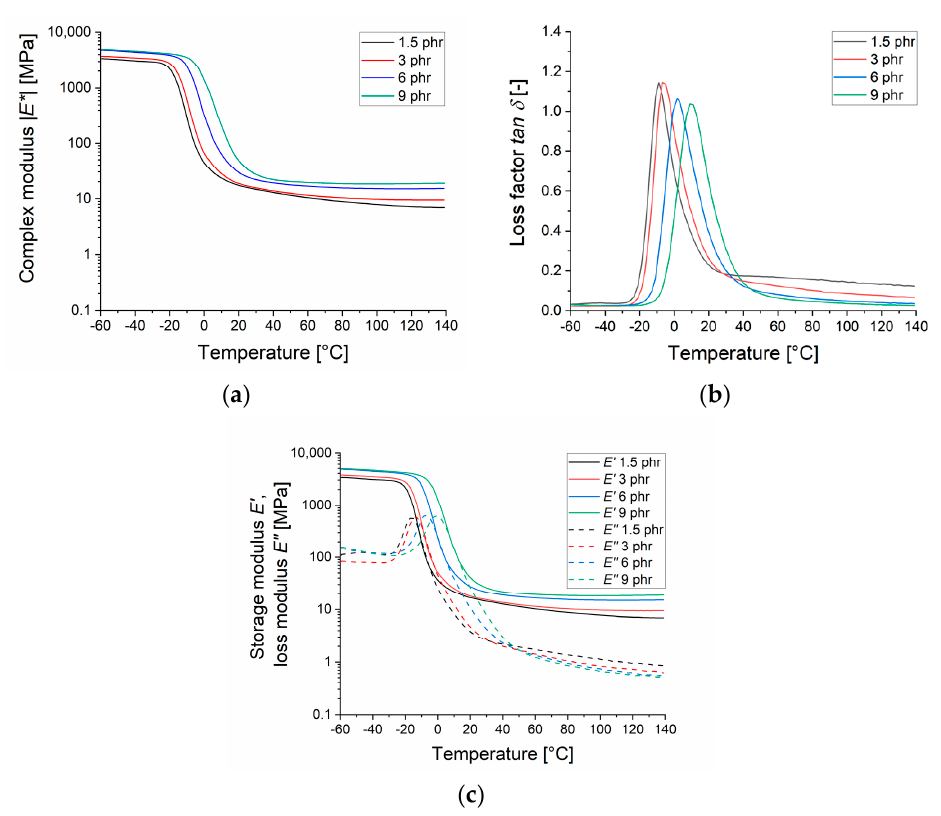
Figure 3. Temperature-dependent dynamic–mechanical curves for different sulfur contents: ( a ) Complex modulus |𝐸 ∗ |; ( b ) loss factor 𝑡𝑎𝑛 𝛿 ; ( c ) storage modulus 𝐸′ and loss modulus 𝐸 (cid:4593)(cid:4593) .